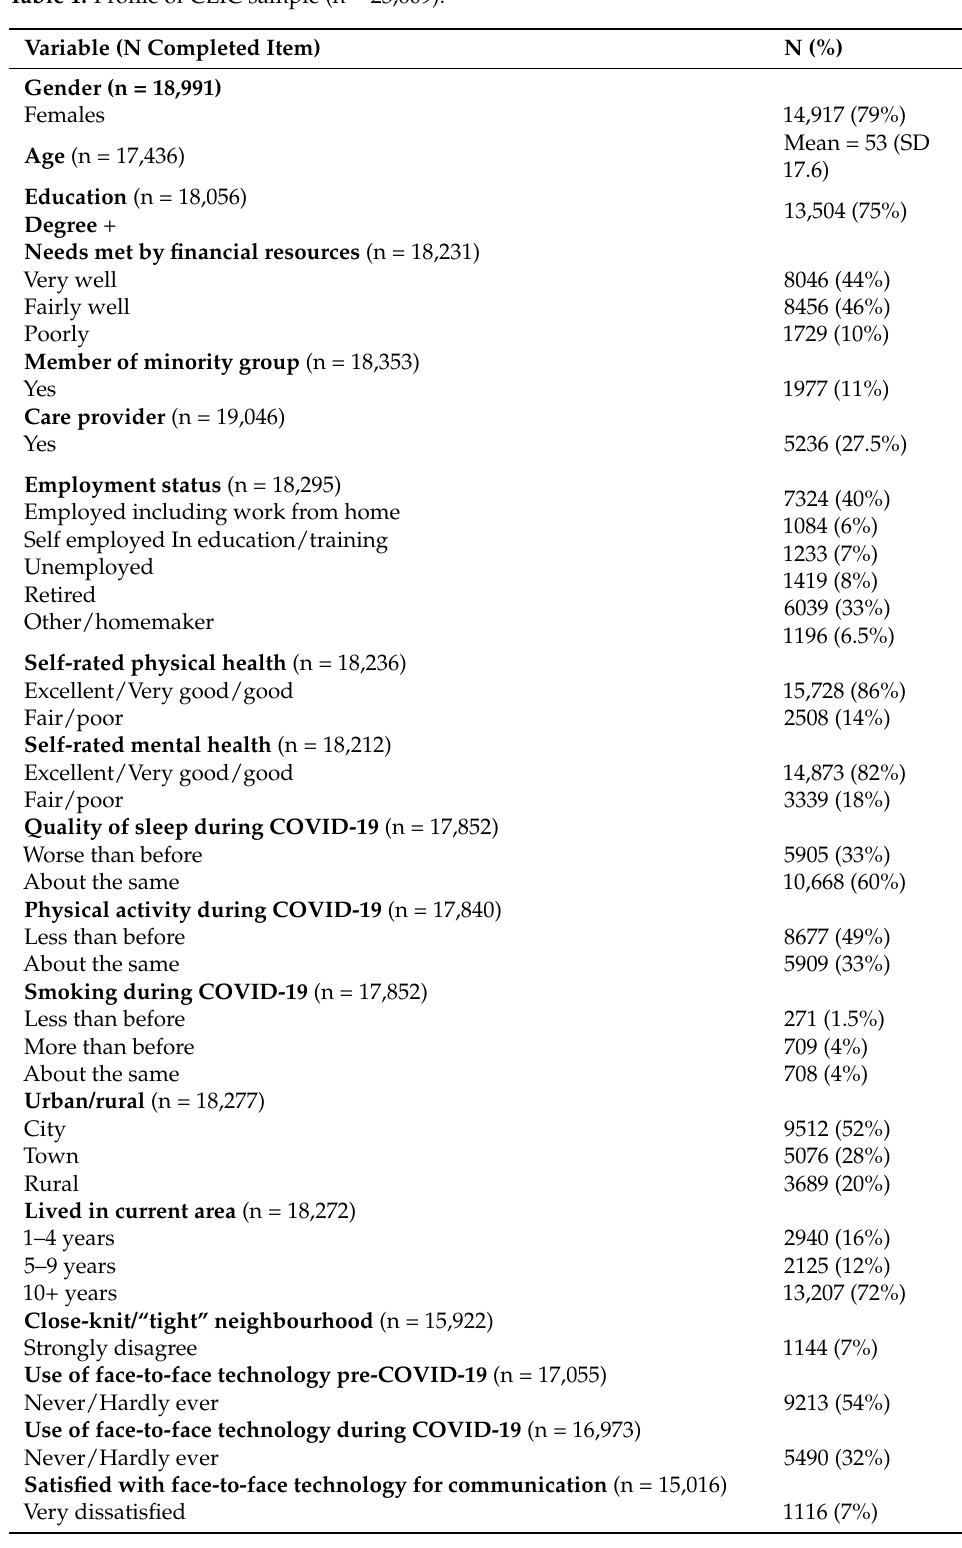
Table 1. Profile of CLIC sample (n =